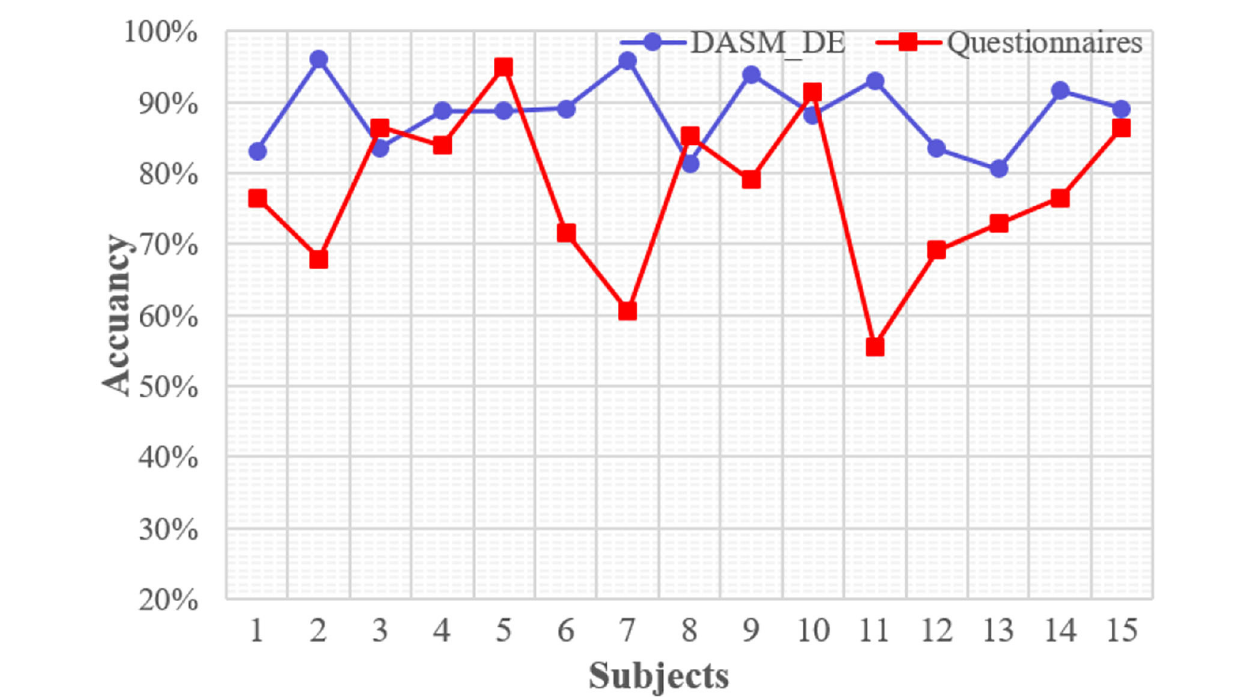
FIGURE 7 | The results of identifying the two types of automobile sounds (namely, powerfulness and acceleration) using SVM with DSAM_DE as the feature and the test subjects in form of a questionnaire.